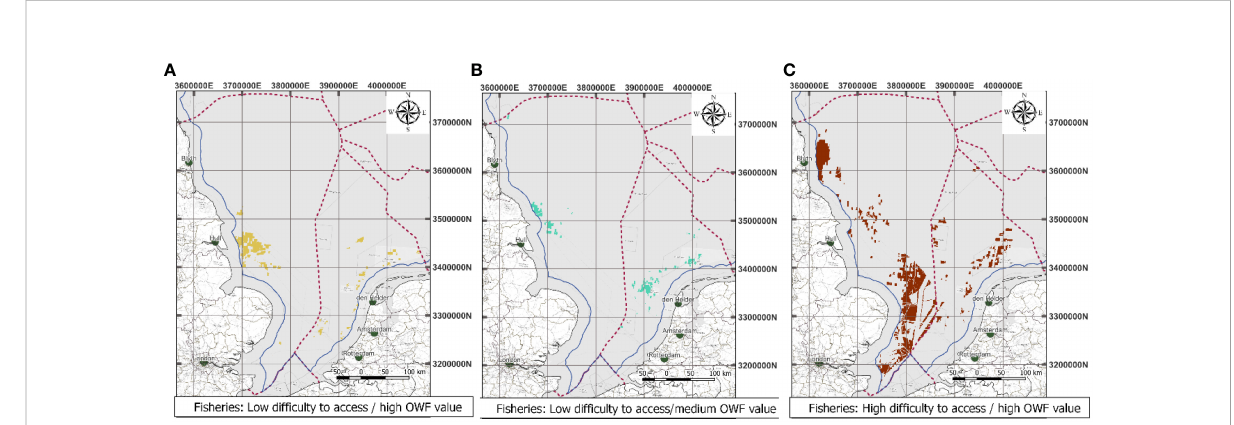
FIGURE 18 Areas of distinct focus for management strategies with fi sheries: (A) low dif fi culty to access (low ACS from 1 or 2 overlaps) and high value for OWF deployment (from (B) low dif fi culty to access and medium value for OWF deployment (C) high dif fi culty to access and high value for OWF deployment.